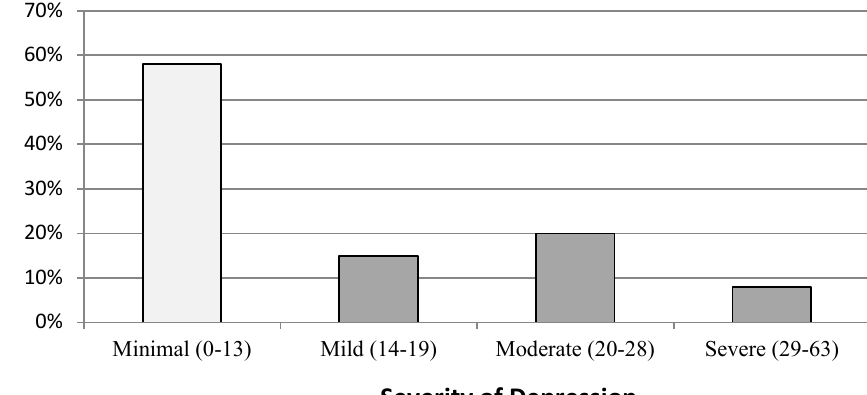
Figure. Patients classified by severity of depression (BDI-II